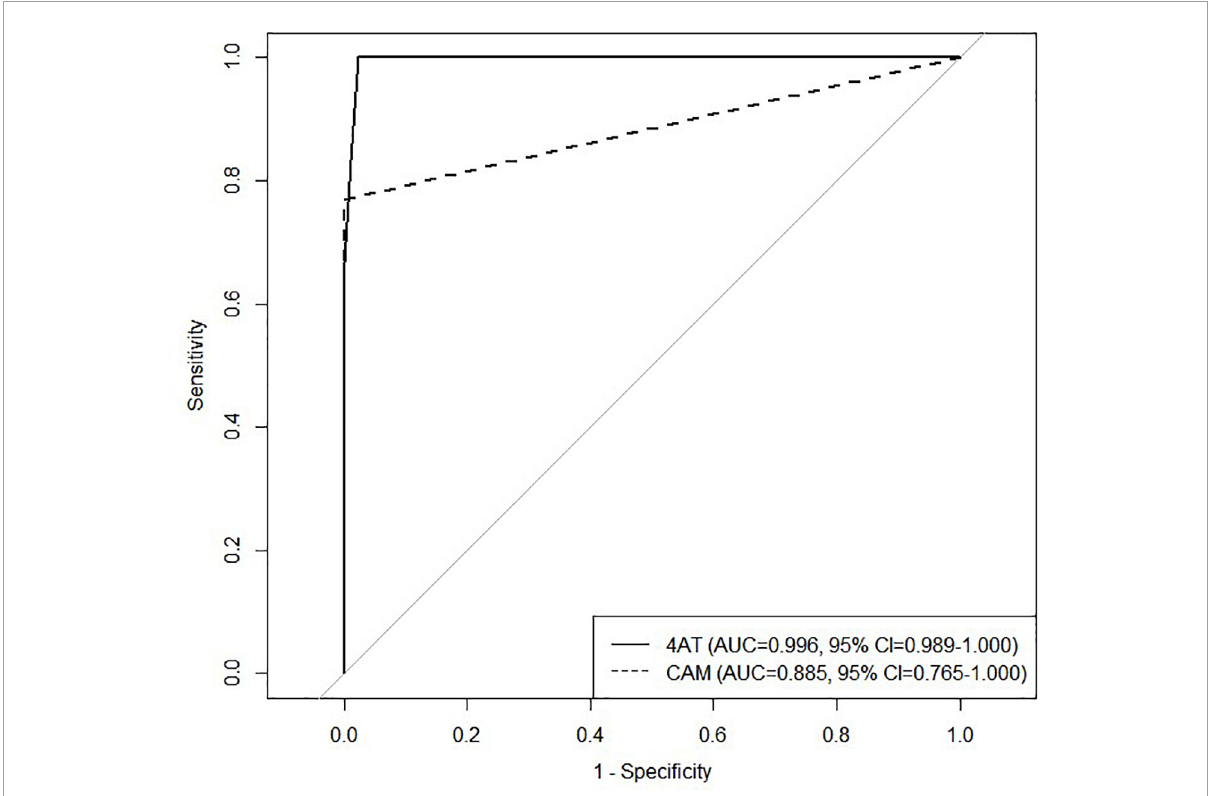
FIGURE2 Receiver operating characteristics (ROC) analysis was performed to compare the 4‘A’s Test (4AT) with the Confusion Assessment Methods (CAM) in Coronavirus disease 2019 (COVID-19) inpatients. ROC, Receiver operating characteristics; 4AT, 4‘A’s Test; CAM, Confusion Assessment Methods; COVID-19, Coronavirus disease